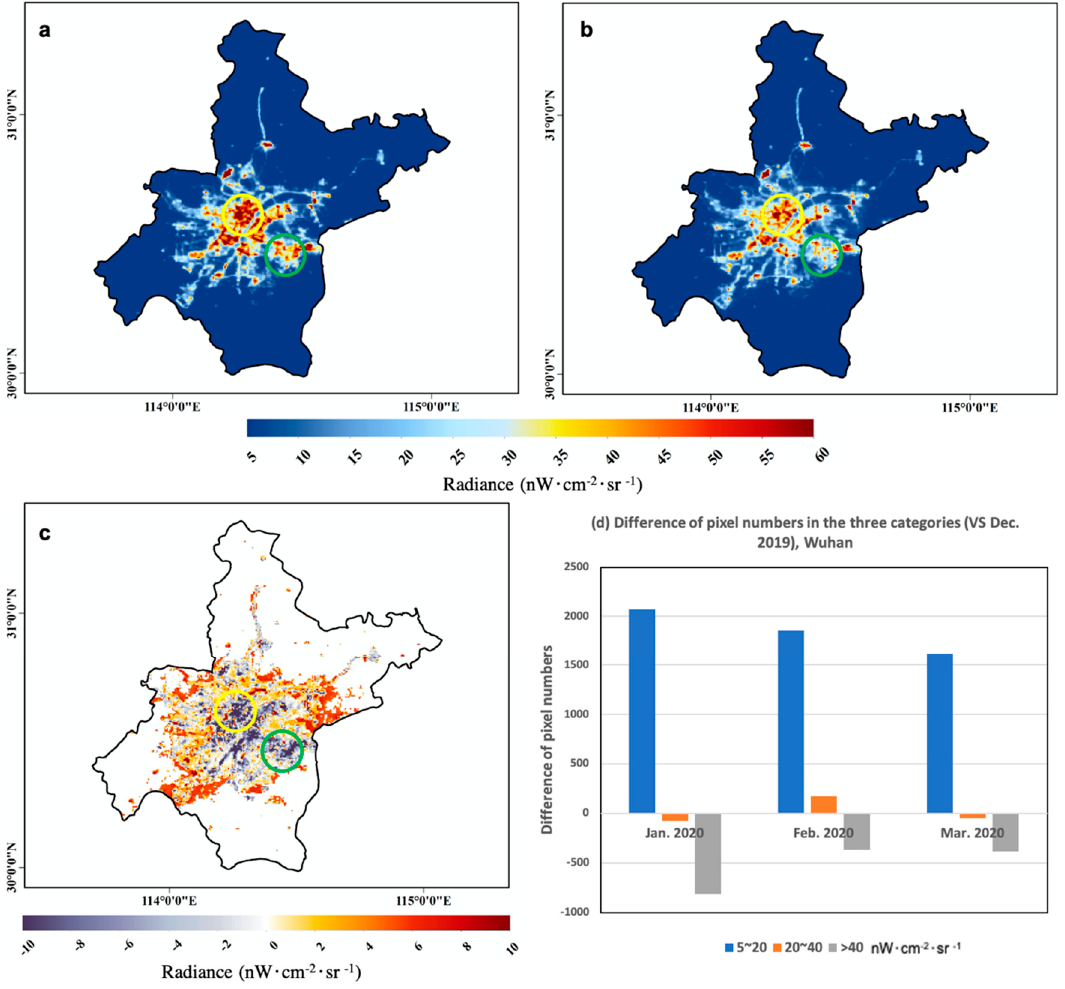
Figure 5. ( a ) Monthly average NTL radiance of Wuhan before lockdown; ( b ) monthly average nighttime light radiance of Wuhan after lockdown; ( c ) difference between (b) and (c); ( d ) differences of NOP in the three NTL categories between first three months of 2020 and December 2019, in Wuhan.